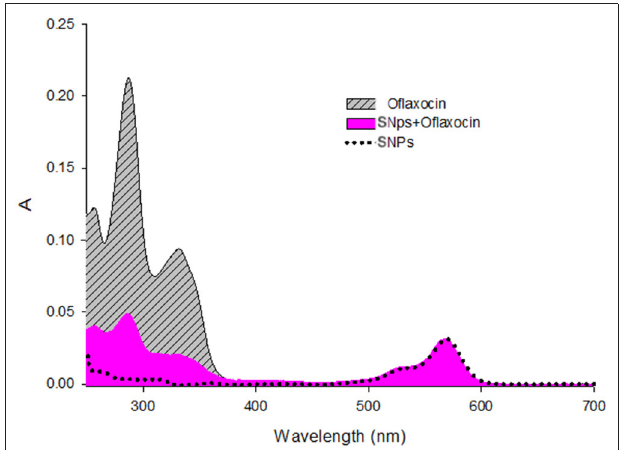
FIGURE 6 | Absorption spectra of Ofloxacin [9.3 µ M], SNPs (nanoparticles) [0.18 µ M], and SNPs + Ofloxacin [0.18 µ M] in PBS pH 7.4.